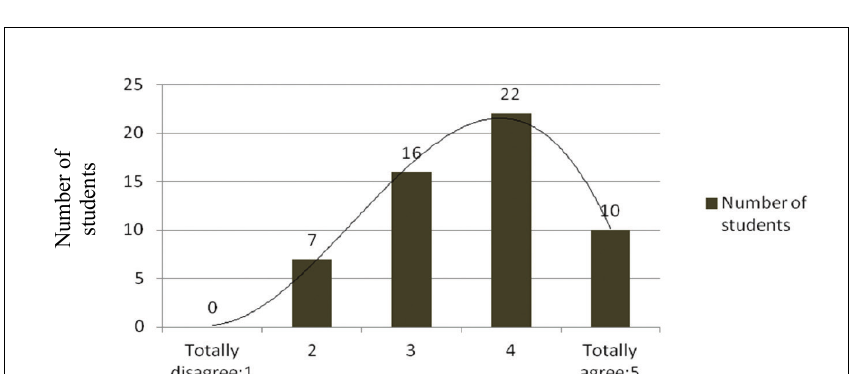
Figure 6. Response to